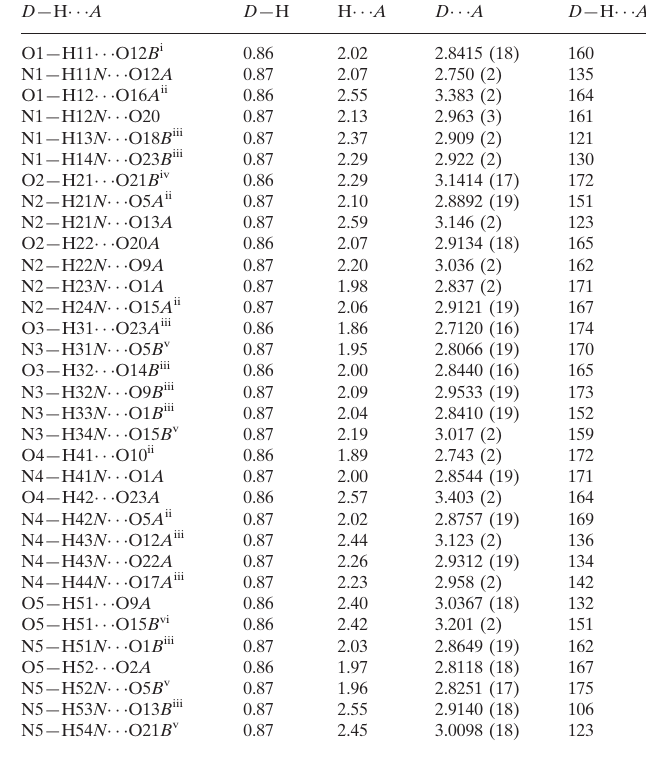
Bruker X8 APEXII Diffractometer Absorption correction: multi-scan ( SADABS ; Bruker, 2005) T min = 0.695, T max = 0.837